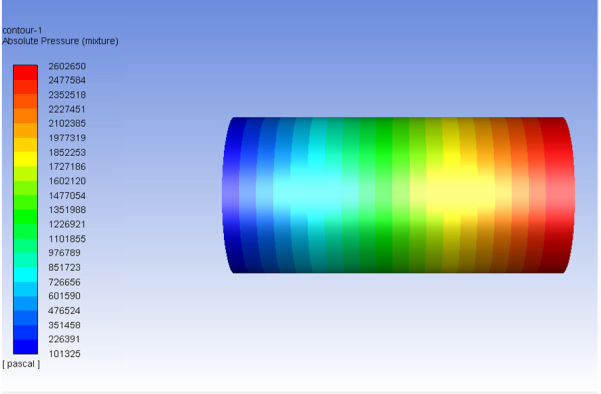
Figure 7. Pressure profile across the core—gaseous carbon dioxide inlet pressure 2.6